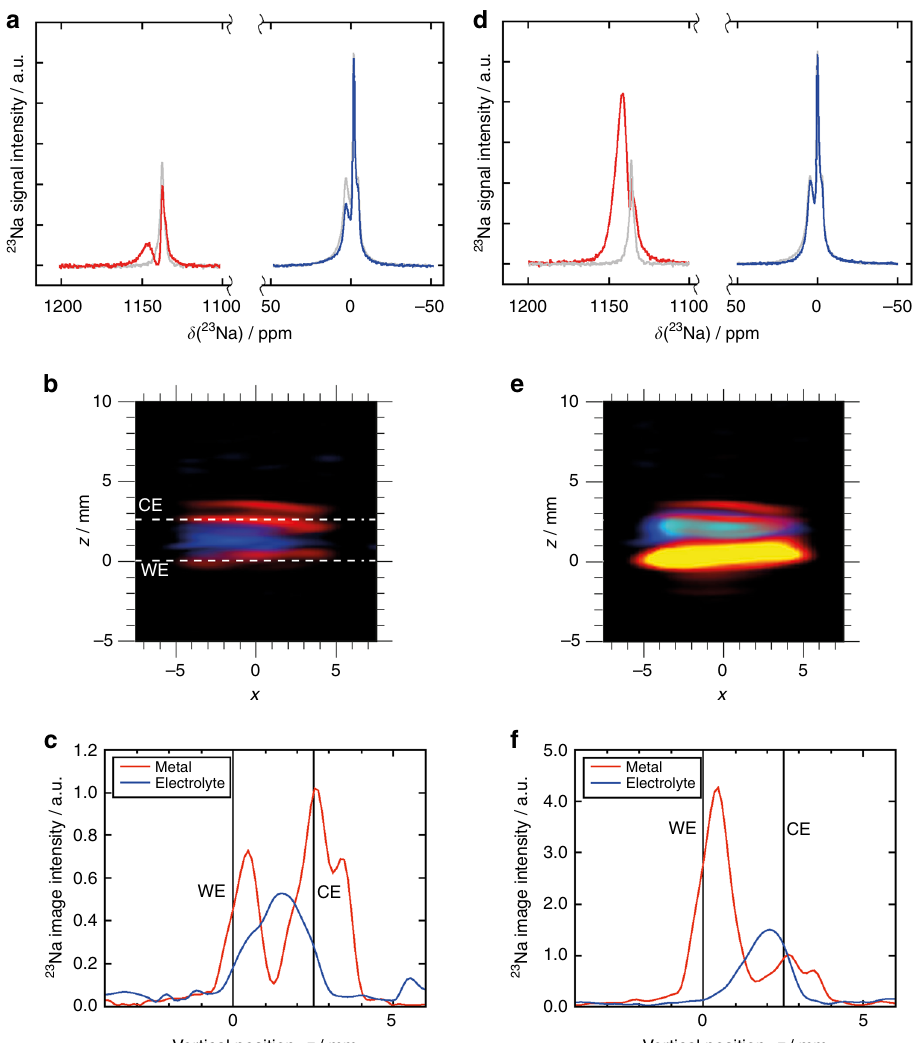
Fig. 3 Evolution of 23 Na NMR signal at the start and after continued galvanostatic plating. a , d 23 Na NMR spectra for solvated Na in the electrolyte (blue line) and for metallic Na (red line), after discharge at a speci fi c current of 150 mA g − 1 ( a ) and after discharge at a speci fi c current of 600 mA g − 1 ( d ). The corresponding spectra for the cell following a single charge cycle (Fig. 2a) are included for comparison as grey lines. b , e 2D 23 Na MRI of metallic (red) and dielectric (blue) sodium in the cell, after discharge at a speci fi c current 150 mA g − 1 ( b ) and after discharge at a speci fi c current 600mA g − 1 ( e ). c , f 1D 23 Na MR pro fi le of metallic and dielectric sodium in the cell, after discharge at a speci fi c current 150 mA g − 1 ( c ) and after discharge at a speci fi c current 600 mA g − 1 ( f ). This cell was assembled with two